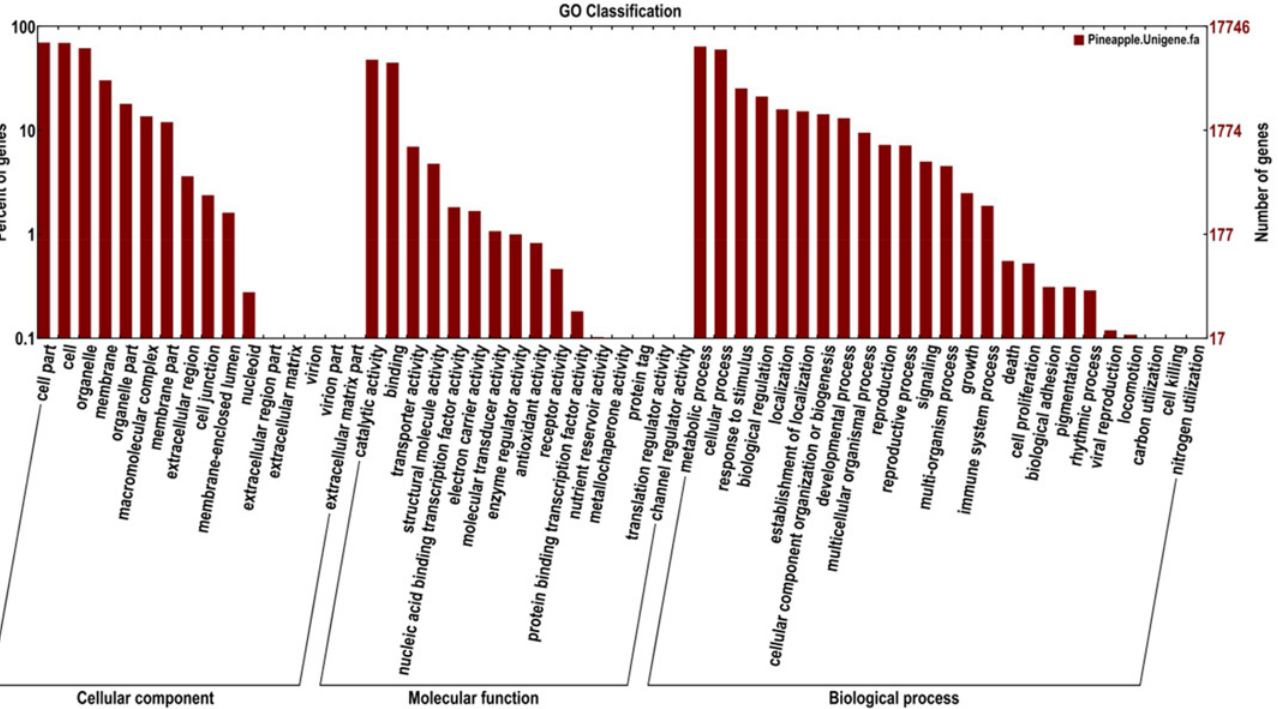
Fig 3. Functional annotation of assembled sequences based on gene ontology (GO) categorization. GO analysis was performed at the level two for three main categories (cellular component, molecular function and biological process).